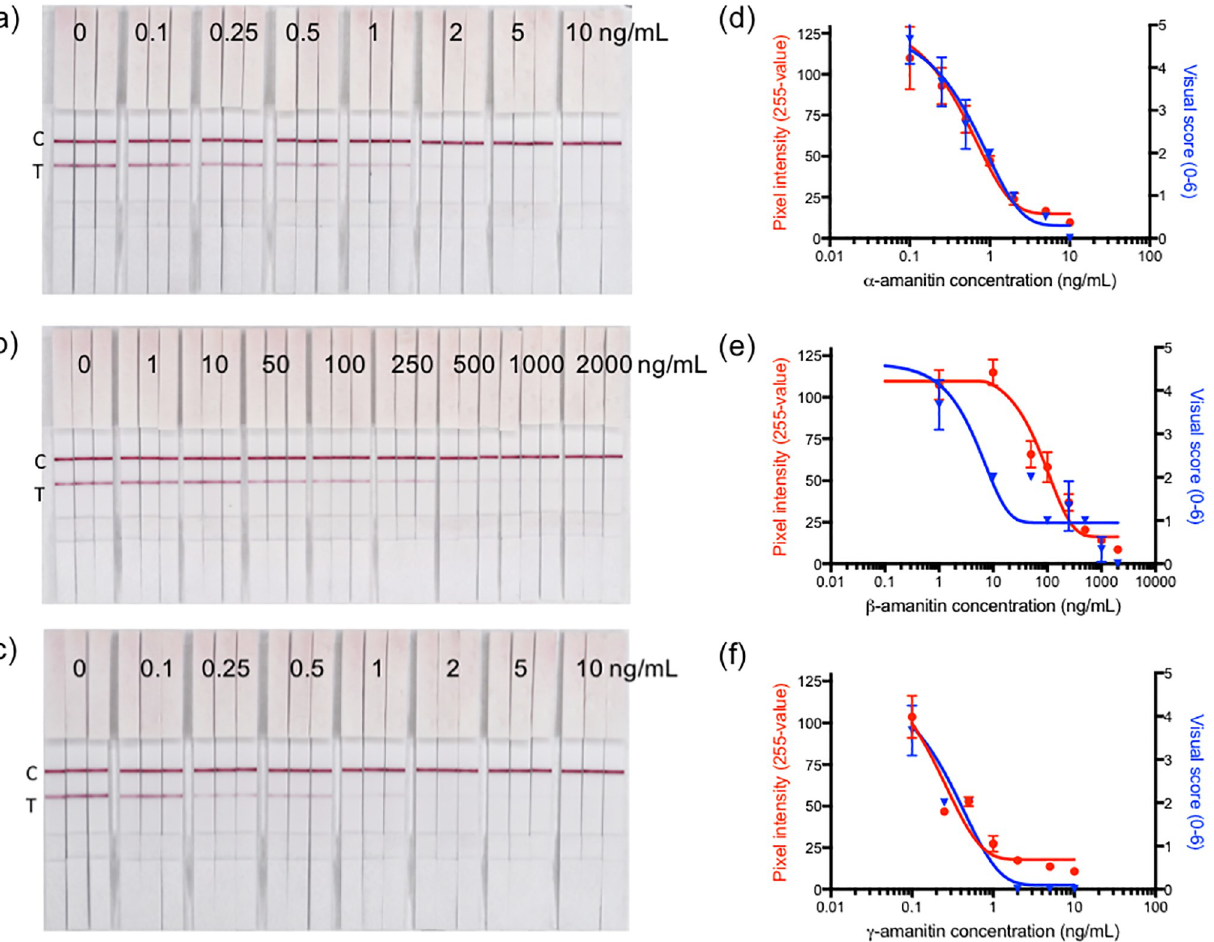
Fig 4. LFIA detection of amatoxins. Standard calibration curves of (a) α -amanitin, (b) β -amanitin, and (c) γ -amanitin determined by lateral flow immunoassay (LFIA). The images on the left (a-c) are the test strips. The graphs to the right (d-f) are the test line pixel values (red circles) and visual score values (blue triangles) from the corresponding image (a-c) expressed as a mean ± standard error, for three separate strips.